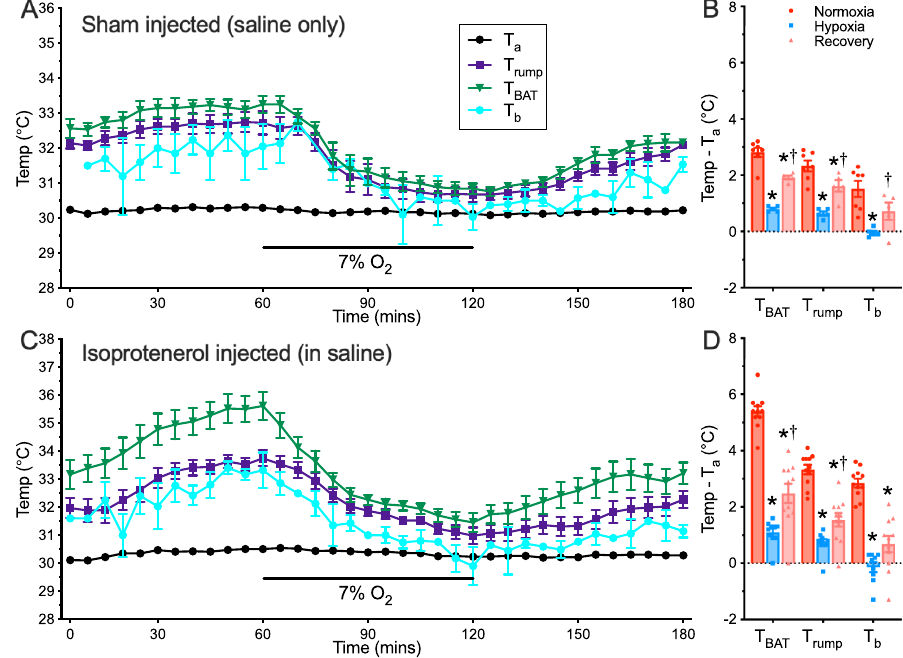
Fig. 3 Adrenergic stimulation enhances non-shivering thermogenesis in normoxia, but not in hypoxia. A , C Summaries of ambient temperature ( T a , black circles), core body temperature ( T b , teal circles), interscapular brown adipose tissue temperature ( T BAT , green triangles), and dorsal skin surface temperature ( T rump , blue squares) from naked mole-rats exposed to a normoxia → hypoxia → recovery protocol in 30 °C following injection of saline ( A , n = 5 independent animals), or isoproterenol ( C , n = 11 independent animals). B , D Summaries of temperature difference between physiological temperatures and T a for the same animals as in ( A , C ). Data are mean ± SEM. Asterisks indicate signi fi cant difference from normoxic controls; daggers indicate a signi fi cant difference from hypoxia (repeated measures ANOVA with Tukey post-test; F 4,9 = 0.5272, p < 0.7190 for shams, F 2,30 = 41. 2, p < 0.0001 for isoproterenol). Source data are provided as a Source Data fi